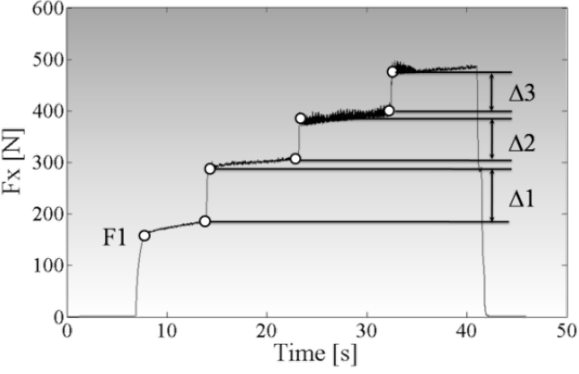
Figure 3: Example of a single direction signal force measurement using four different feed rates.